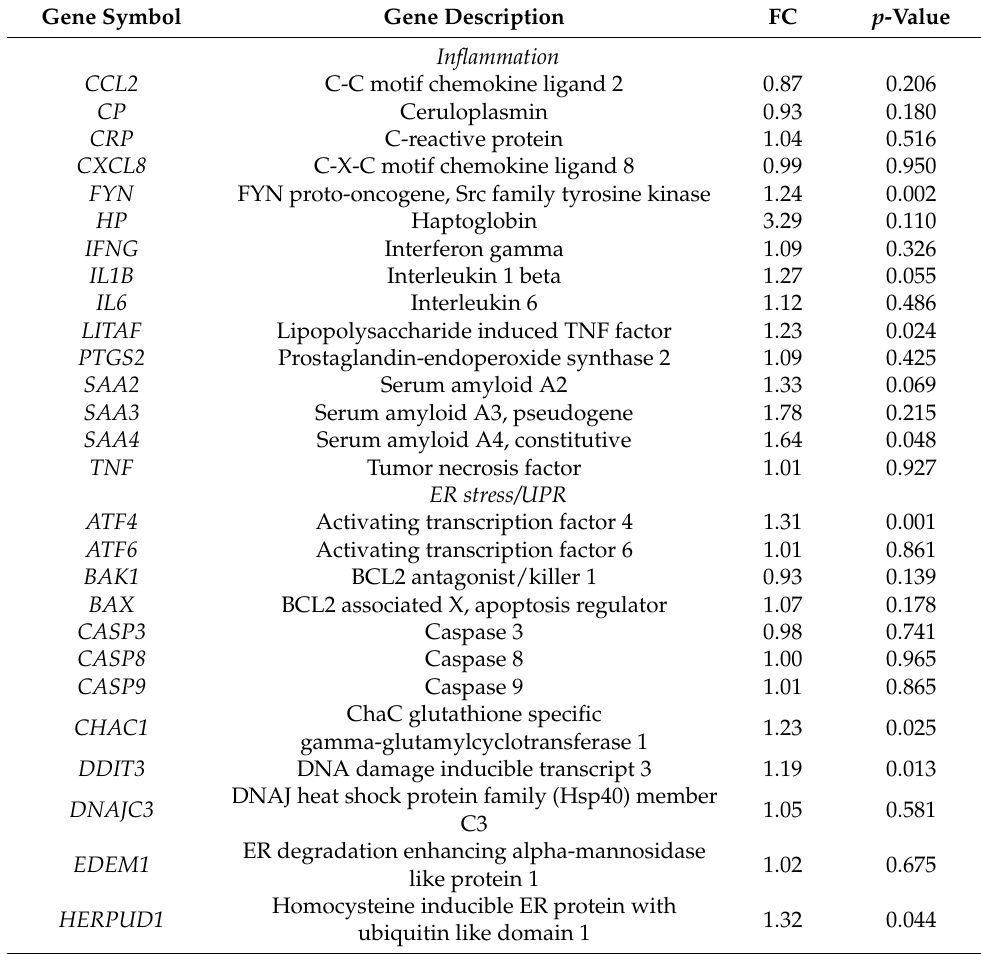
Table 4. Expression [fold change (FC)] of hepatic genes involved in inflammation, endoplasmic reticulum (ER) stress/unfolded protein response (UPR), and nuclear factor erythroid 2-related factor 2 (Nrf2)-dependent cytoprotection in cows with high vs. low hepatic FGF21 expression at week 1